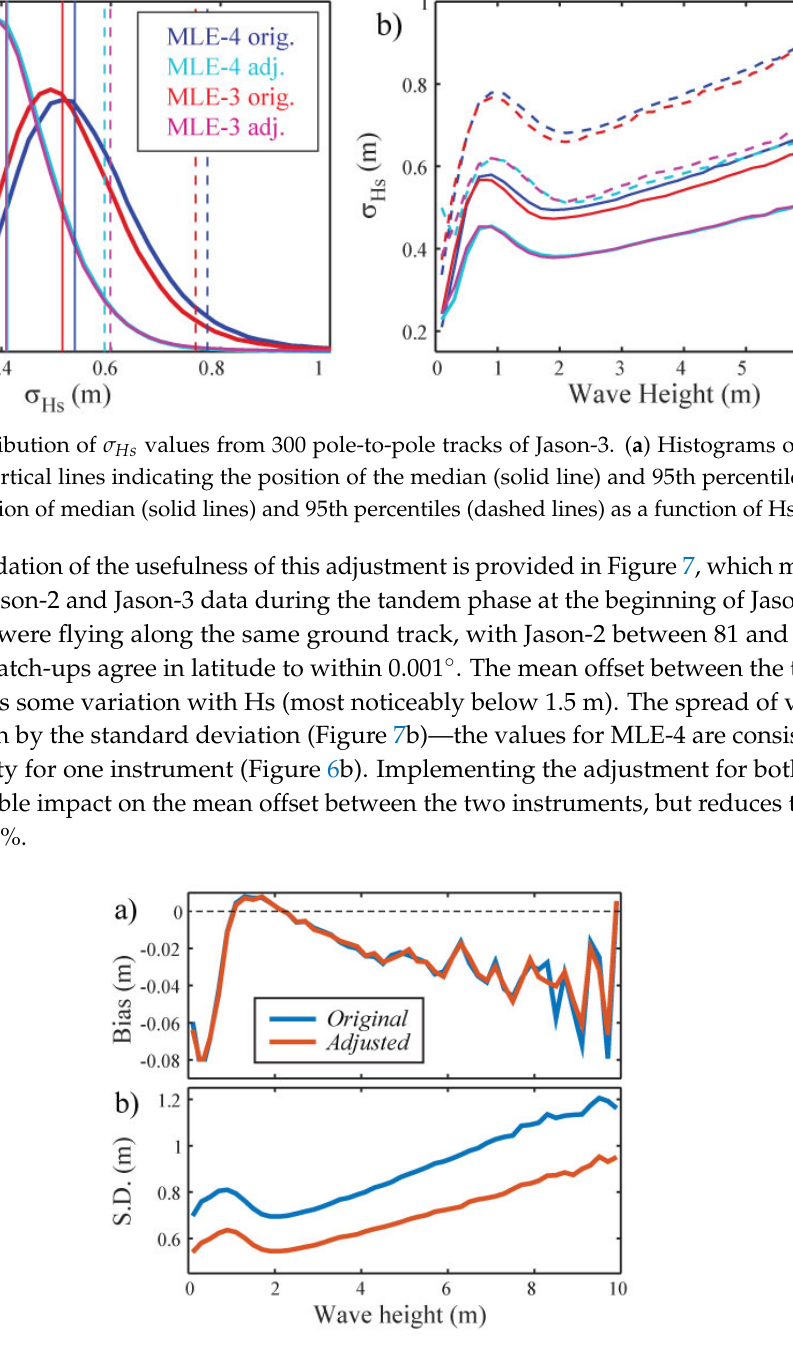
Figure 7. Comparison of near-simultaneous 20 Hz measurements by Jason-2 and Jason-3. ( a ) Bias of Jason-2 relative to Jason-3. ( b ) Scatter (S.D.) of the measurements in each 0.2 m wide Hs